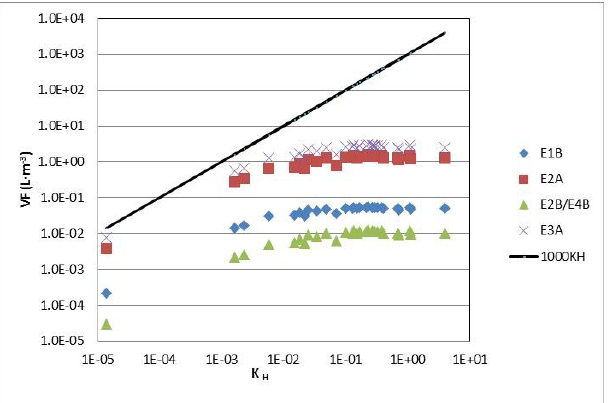
for spherical droplets geometry. H